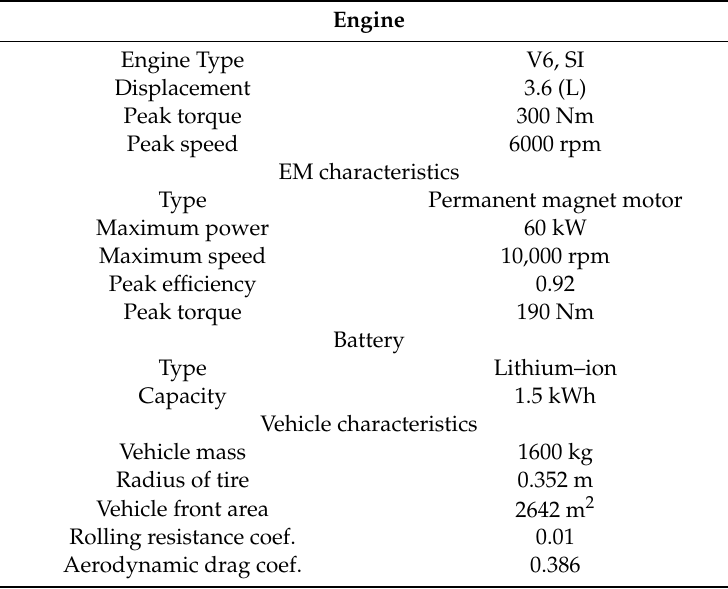
Table 1. Vehicle parameters.